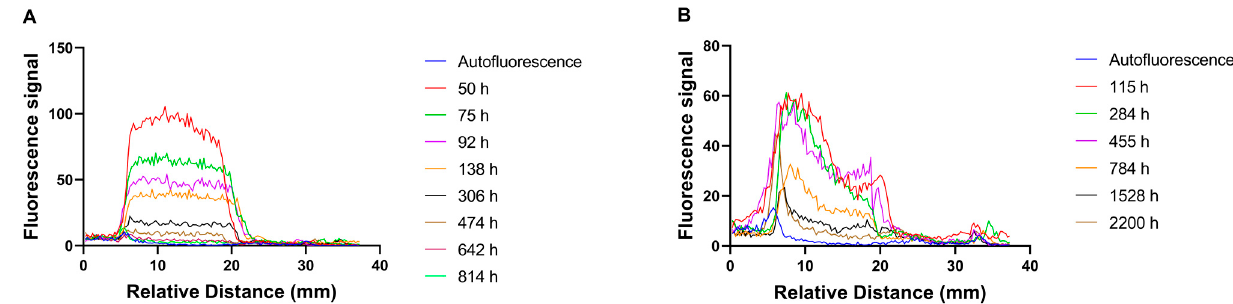
Figure 2. Example fluorophotometer scans of rabbit eyes after injections of ( A ) polymer micelles and ( B ) polymersomes into the rabbit vitreous. Relative distance at about 7–18 mm shows the fluorescence levels in the rabbit vitreous. Autofluo- rescence is shown as blue line. The other lines indicate the fluorescence levels at different times post-injection.